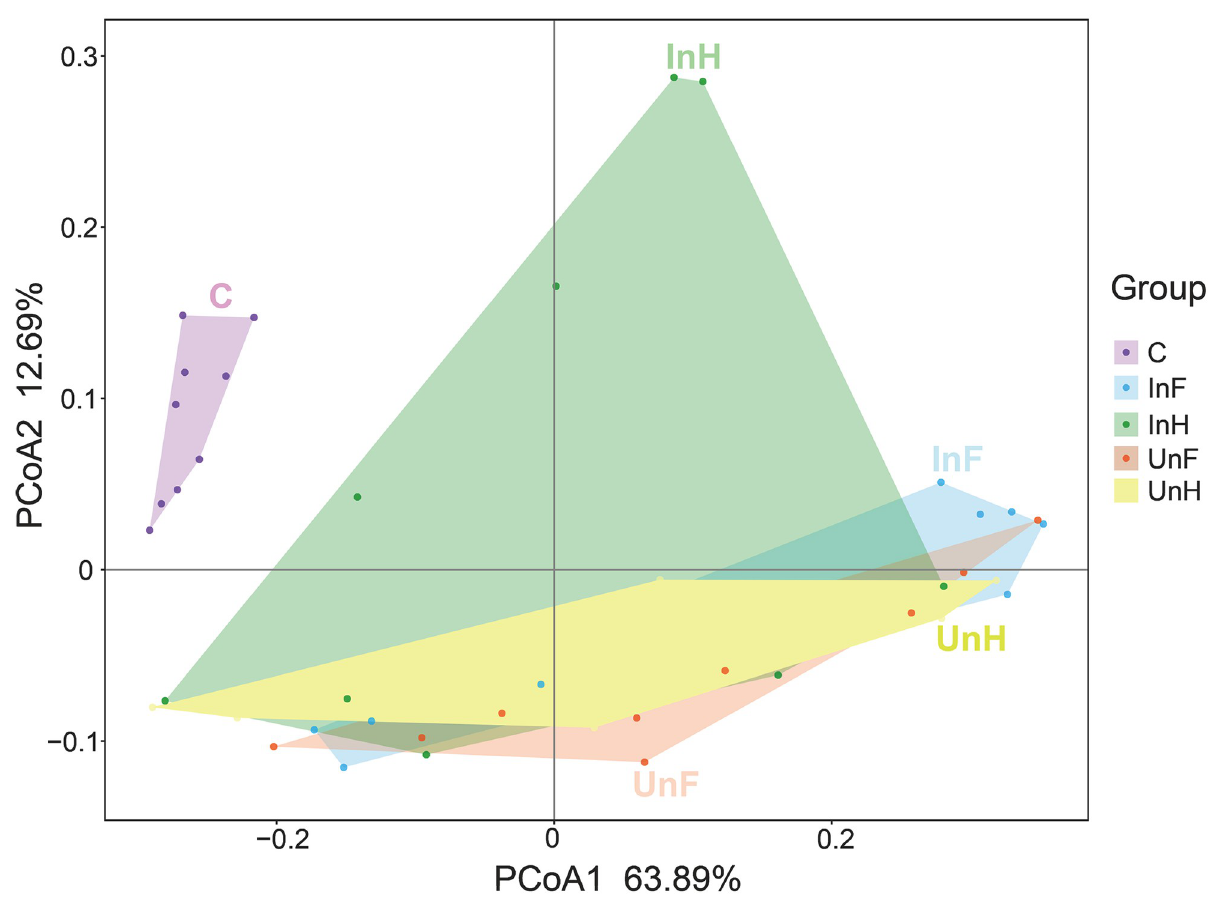
Fig 5. Principal coordinates analysis of microbiota community structures. UnF, uninfected with S . acheilognathi in the foregut of grass carp; UnH, uninfected with S . acheilognathi in the hindgut of grass carp; C, the surface of S . acheilognathi ; InF, infected with S . acheilognathi in the foregut of grass carp; InH, infected with S . acheilognathi in the hindgut of grass carp.